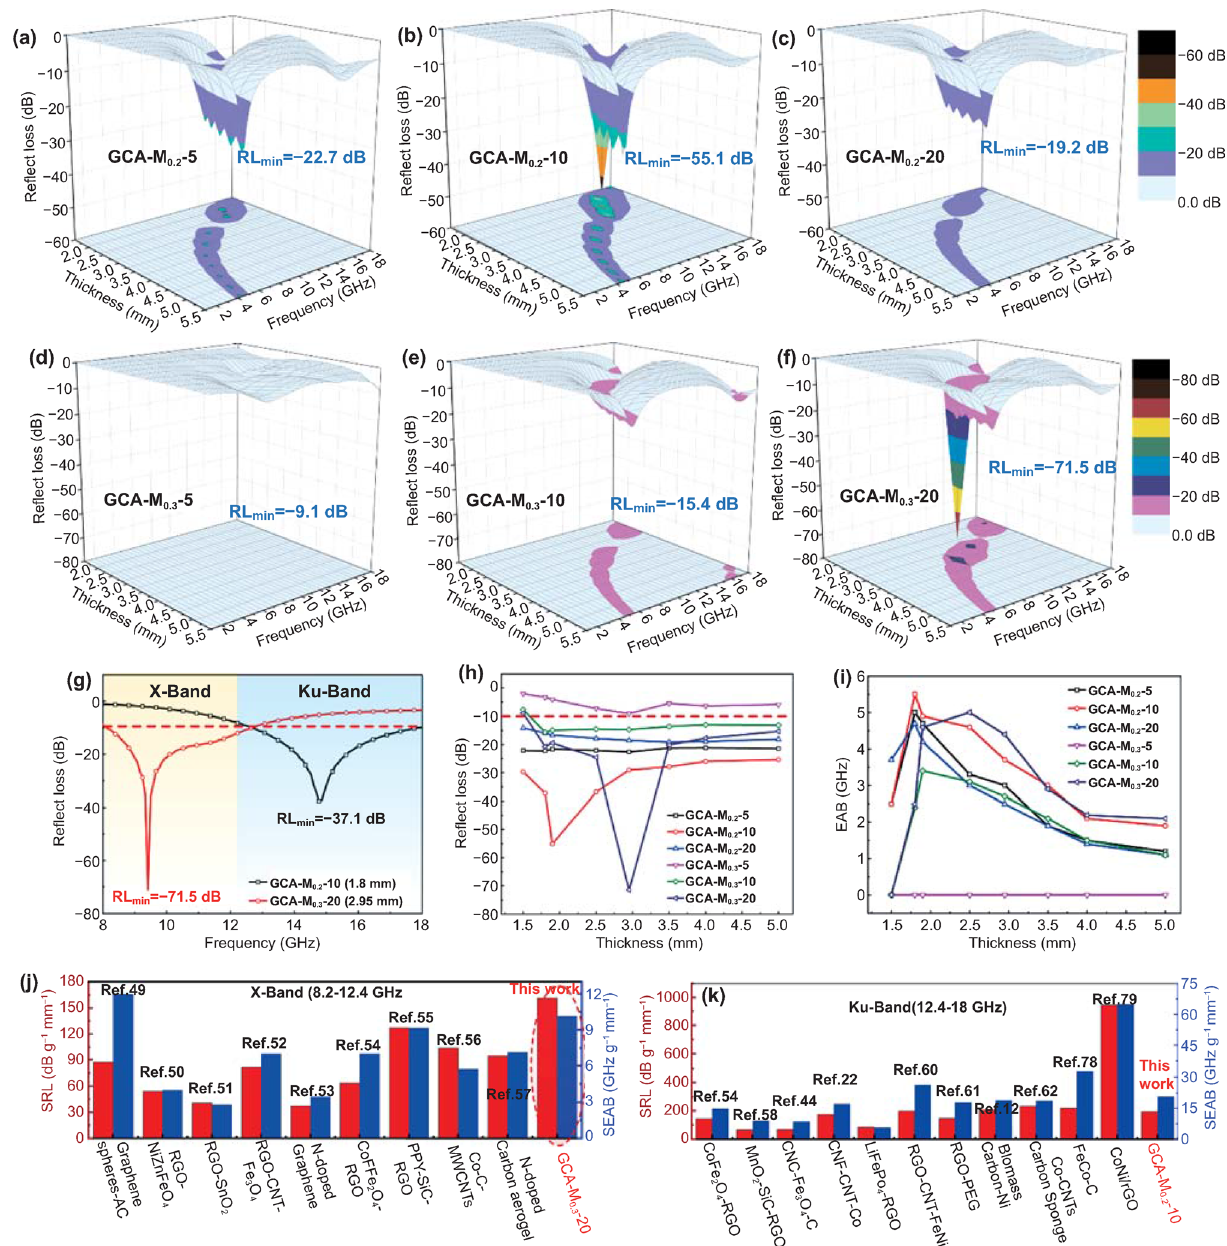
Fig. 5 3D representations of the RL of ( a ) GCA–M 0.2 –5, ( b ) GCA–M 0.2 –10, ( c ) GCA–M 0.2 –20, ( d ) GCA–M 0.3 –5, ( e ) GCA–M 0.3 –10, and ( f ) GCA–M 0.3 –20. ( g ) Maximum EABs of the GCA–M 0.2 –10 and GCA–M 0.3 –10 aerogels. ( h , i ) RL min and EAB values of as-obtained samples with different thicknesses, respectively. ( j , k ) Comparison of specific RL and specific EAB values of recently reported carbon-based aerogels in X- and